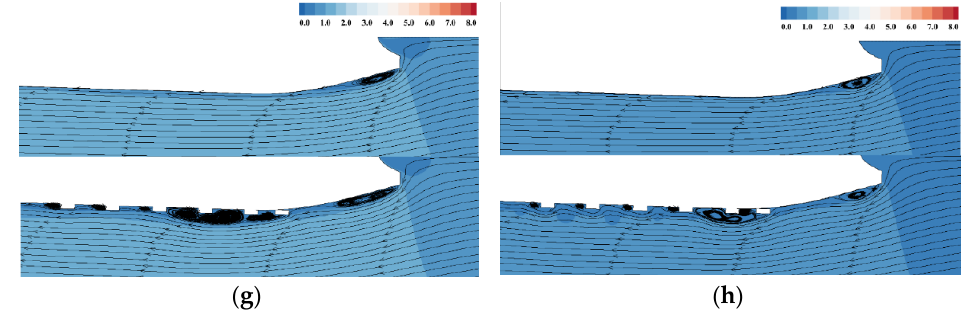
Figure 7. Velocity field distribution: ( a ) 4.0 m/s, ( b ) 3.5 m/s, ( c ) 3.0 m/s, ( d ) 2.5 m/s, ( e ) 2.0 m/s, ( f ) 1.5 m/s, ( g ) 1.0 m/s, and ( h ) 0.5 m/s. (Note: Upper object in the figure for the hull without the aft poppet